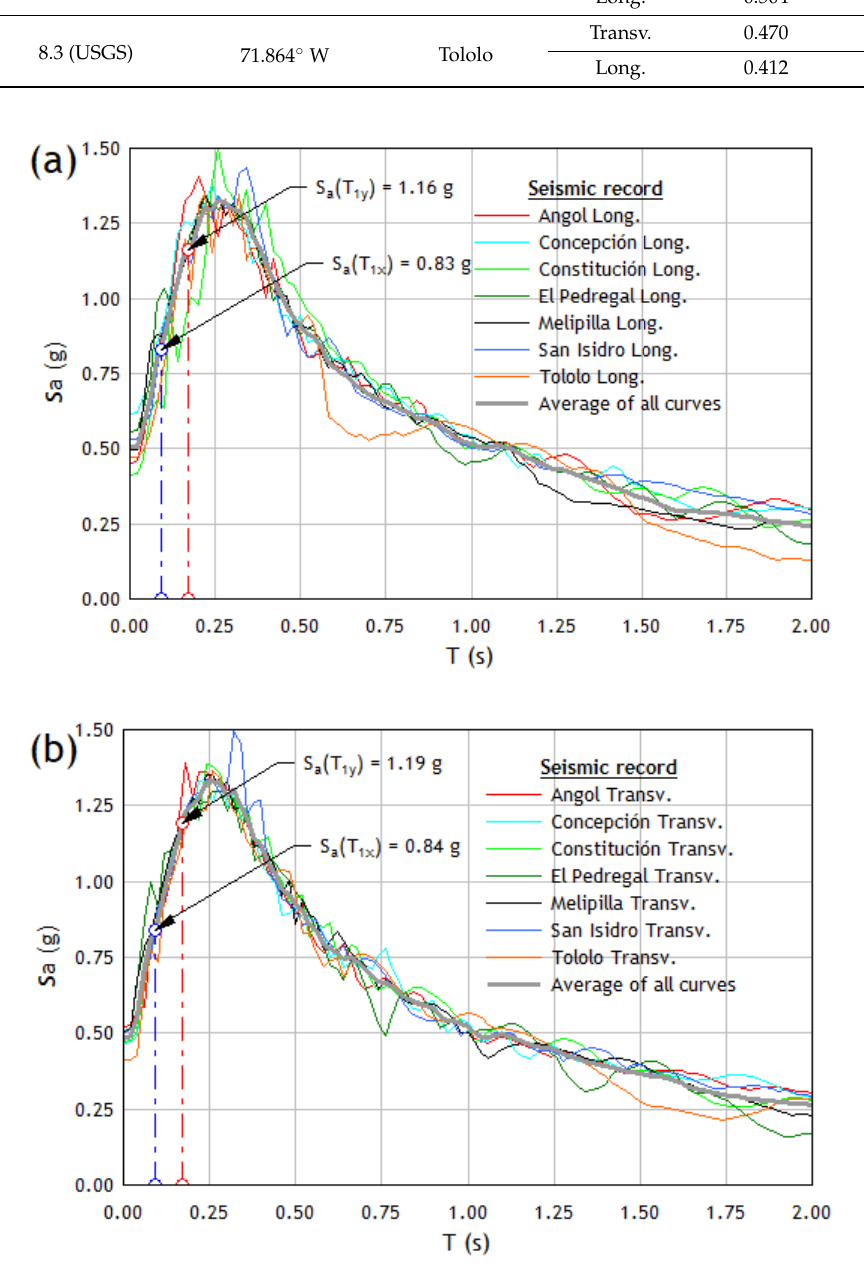
Figure 1. Elastic response spectrum of the chosen acceleration records selected: ( a ) Longitudinal ( b ) Transverse.